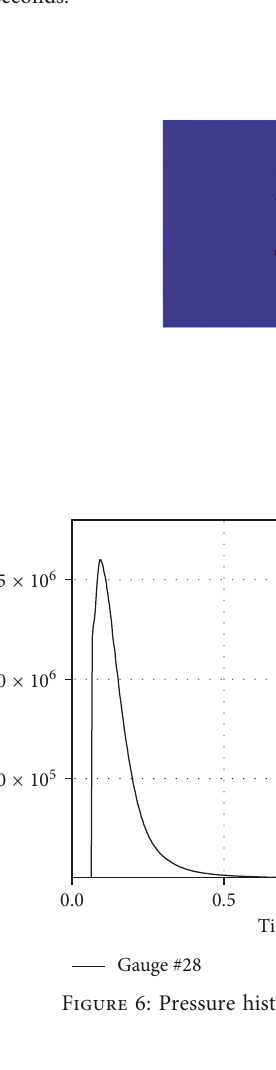
Figure 4: Blast wave spread of above-deck explosive TNT at different times: (a) 0.85 milliseconds, (b) 1.7 milliseconds, and (c) 5.99 milliseconds.